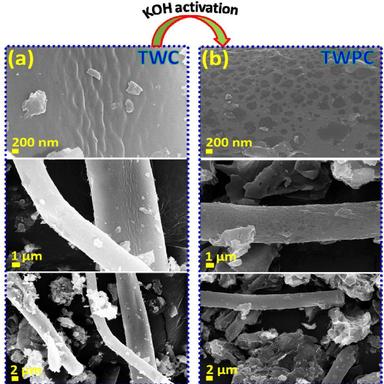
SEM images at different magnification of the as-prepared (a) TWC and (b) TWPC samples.